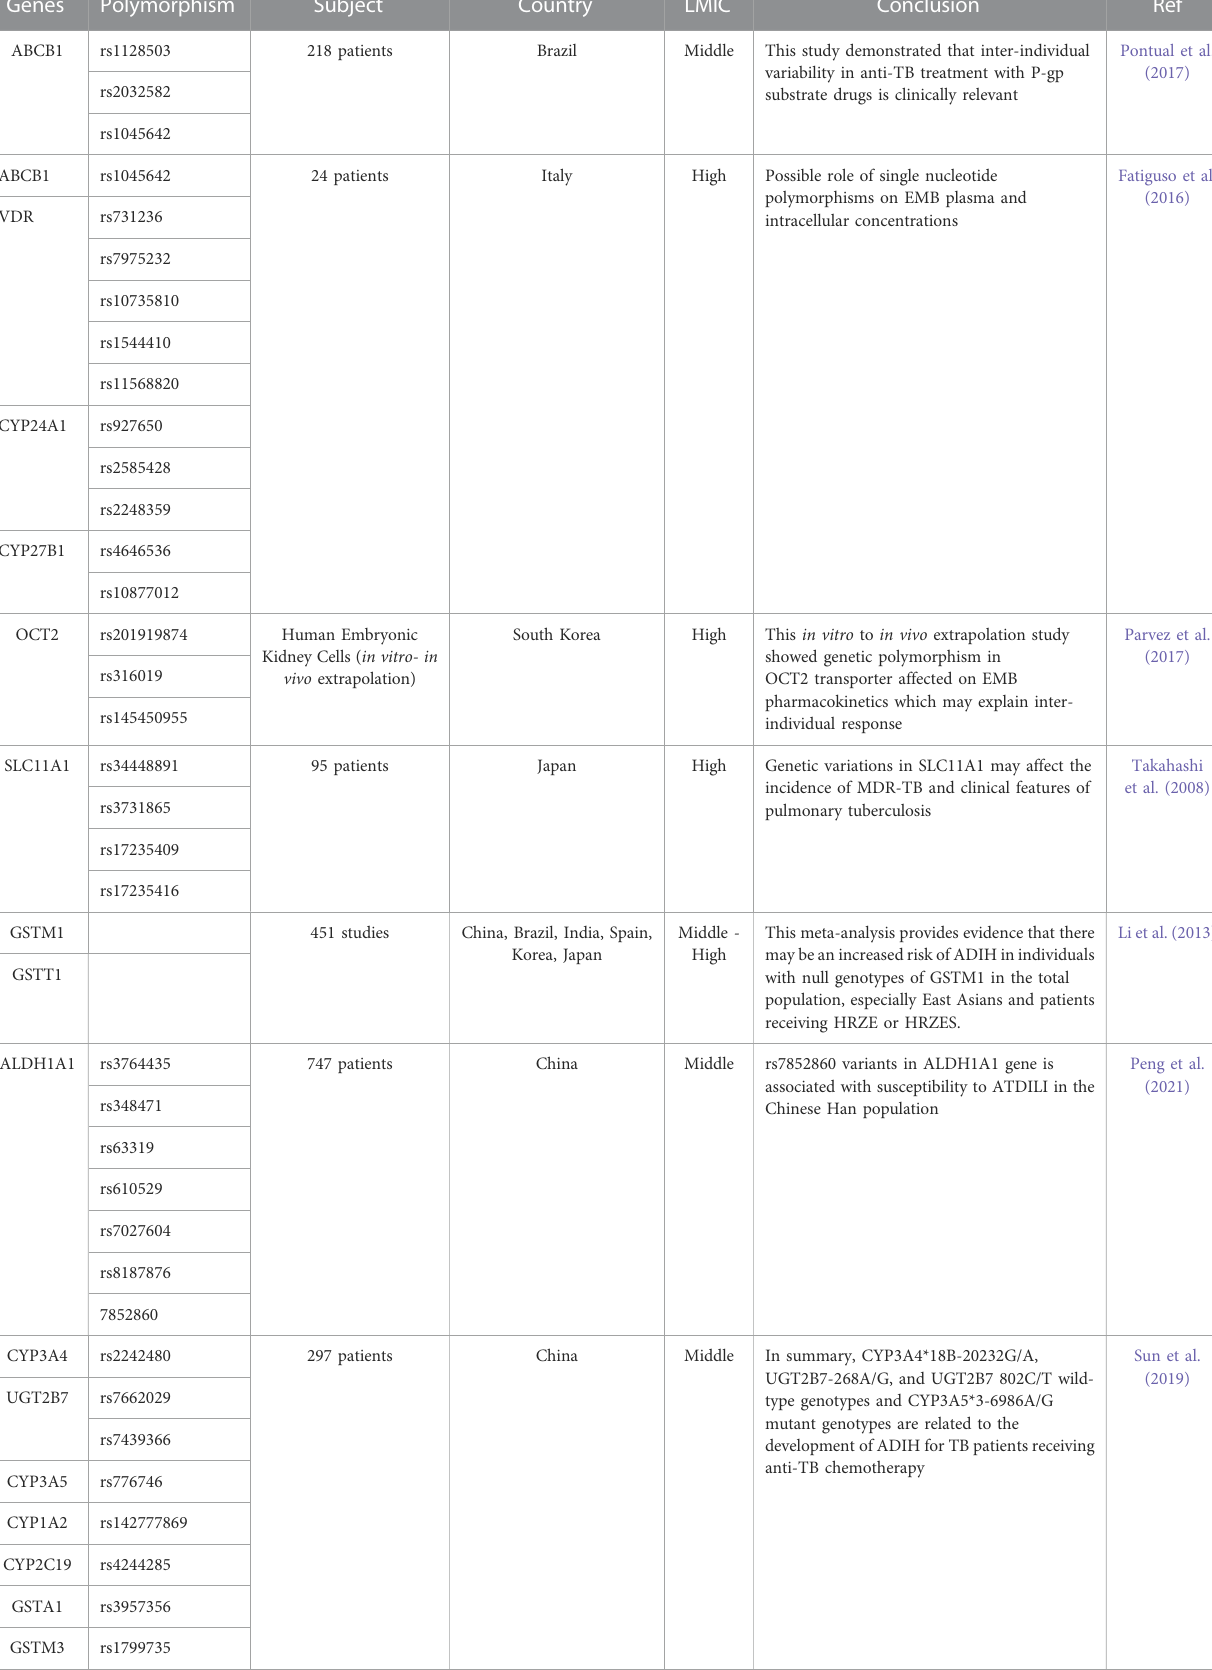
TABLE 1 Genetic polymorphism related to pharmacokinetic